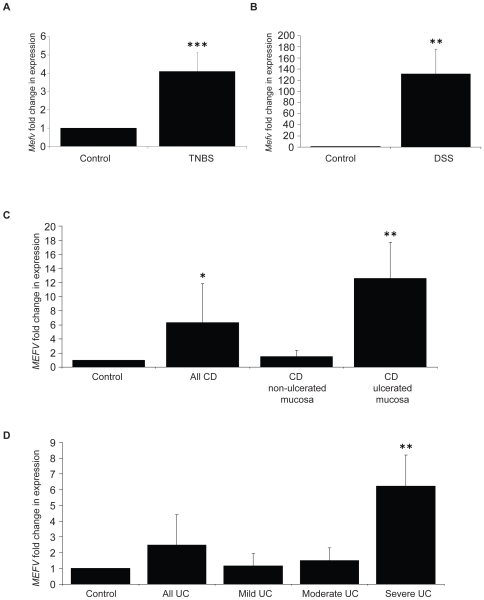
Level of MEFV mRNA expression in inflamed colitis tissues compared to healthy controls.(a, b) MEFV expression was assessed by quantitative real-time PCR in (a, b) healthy mice colons (n = 7), in colons from (a) TNBS-induced (n = 8) and (b) DSS-induced (n = 4) colitis mice models, as well as in (c, d) healthy human (n = 25), (c) CD (n = 16) and (d) UC (n = 17) colonic specimens. MEFV expression appeared to correlate with disease severity in both CD (c: 9 CD with mild inflammation and 7 CD with severe inflammation) and UC (d: 6 UC with mild inflammation, 7 UC with moderate inflammation and 4UC with severe inflammation) samples. (a–d) Expression was normalized to 18S gene expression and each bar represents the mean value±S.D. (*) = p<0.05 compared to healthy colonic specimens, considered as the arbitrary baseline = 1.